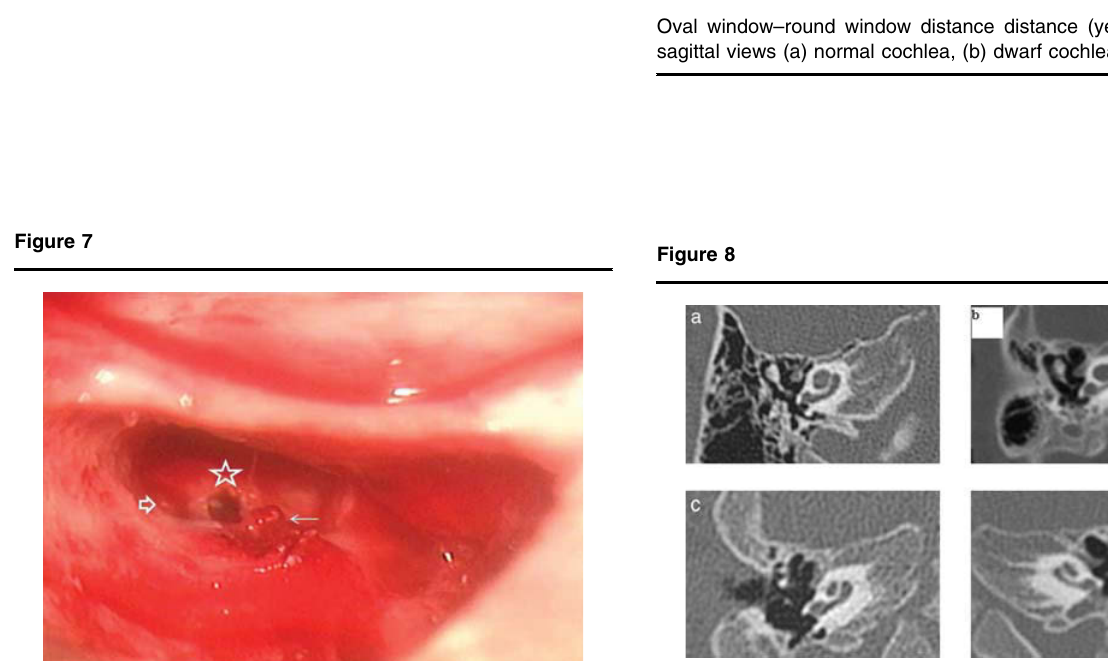
Appearance of a hypoplastic cochlea in computed tomography nor- mal cochlea for comparison (a) and different patients with cochlear hypoplasia (c, d). An incomplete partition (b) for differentiation [7].